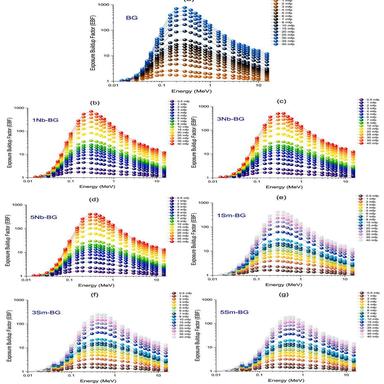
a–g). Exposure buildup factor (EBF) values of bioactive glasses under examination; (a) BG, (b) 1Nb-BG, (c) 3Nb-BG, (d) 5Nb-BG, (e) 1Sm-BG, (f) 3Sm-BG, (g) 5Sm-BG.